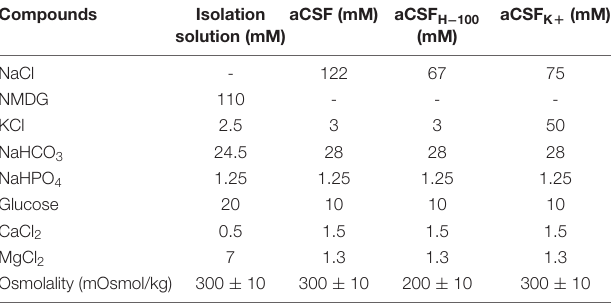
TABLE 1 | Composition of the solutions.